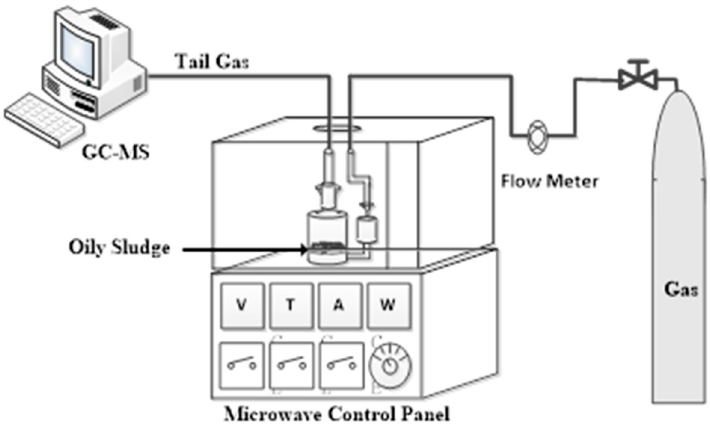
Figure 1. Experimental equipment.